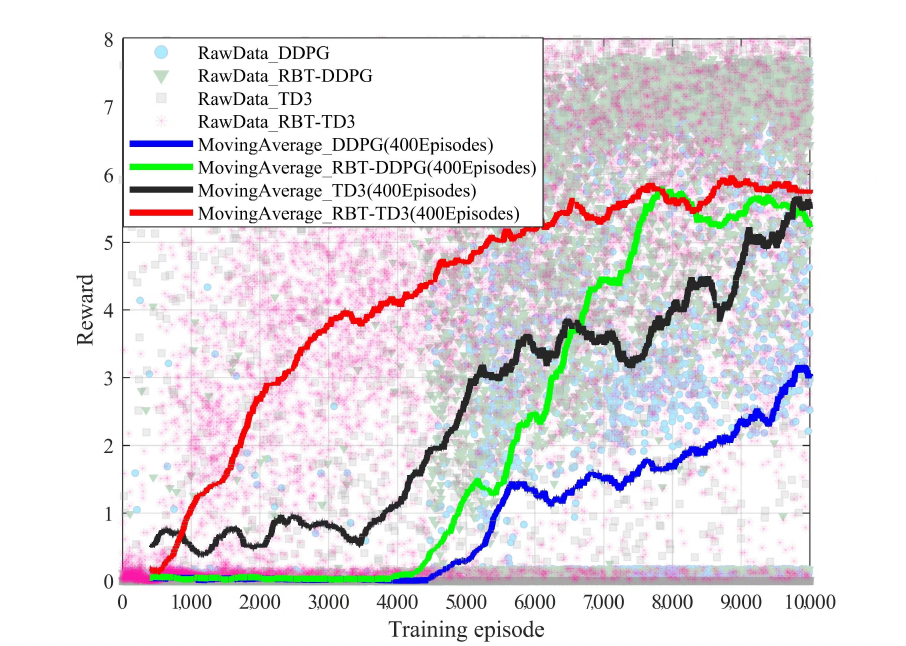
Figure 4. Cumulative reward during training. With the help of the RBT mechanism, both DDPG and TD3 reached a faster training